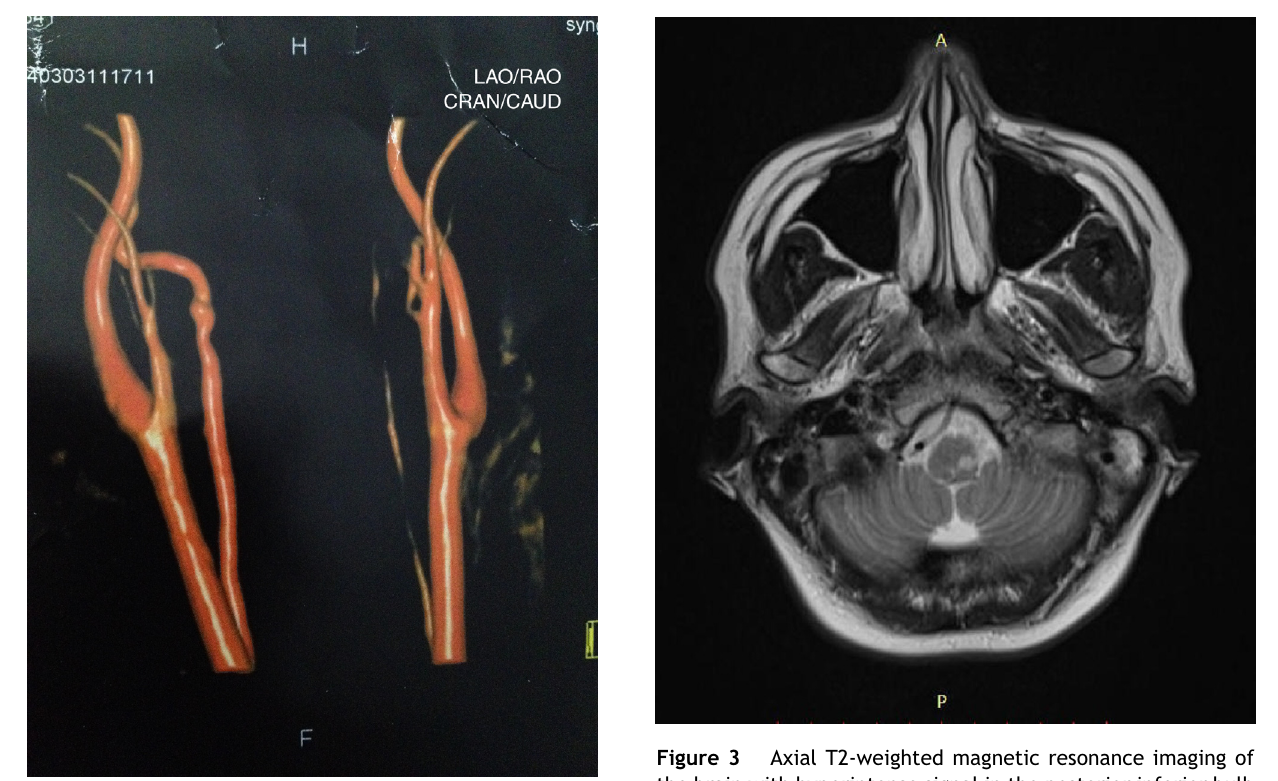
Figure 1 Angioresonance showing a filling defect of left ver- tebral artery, suggestive of vertebral artery dissection. and resulted in a slow and gradual clinical improvement.